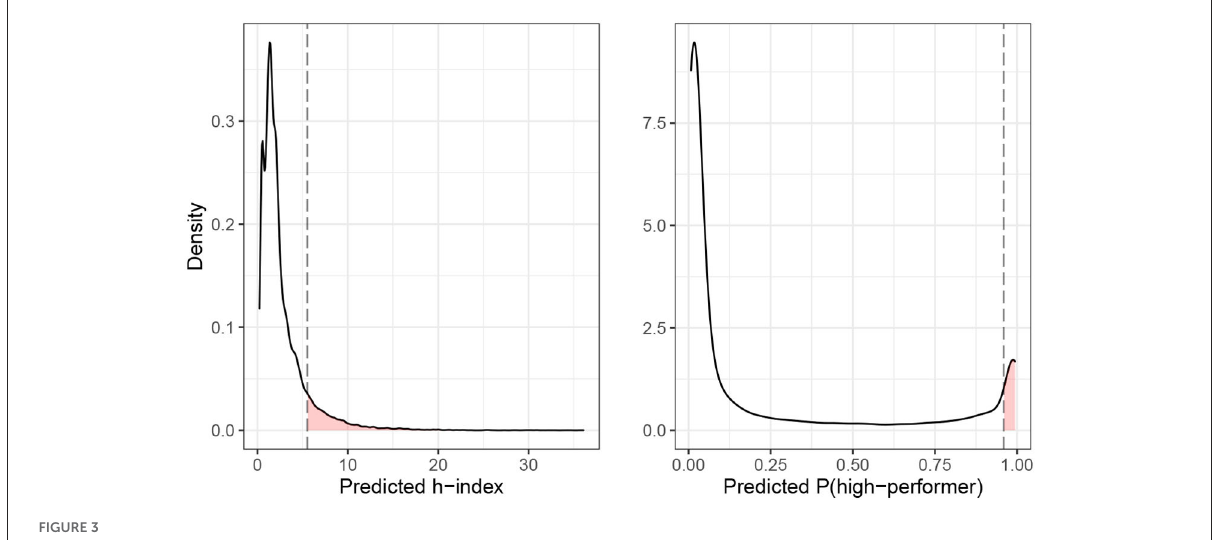
FIGURE3 Illustration of desert